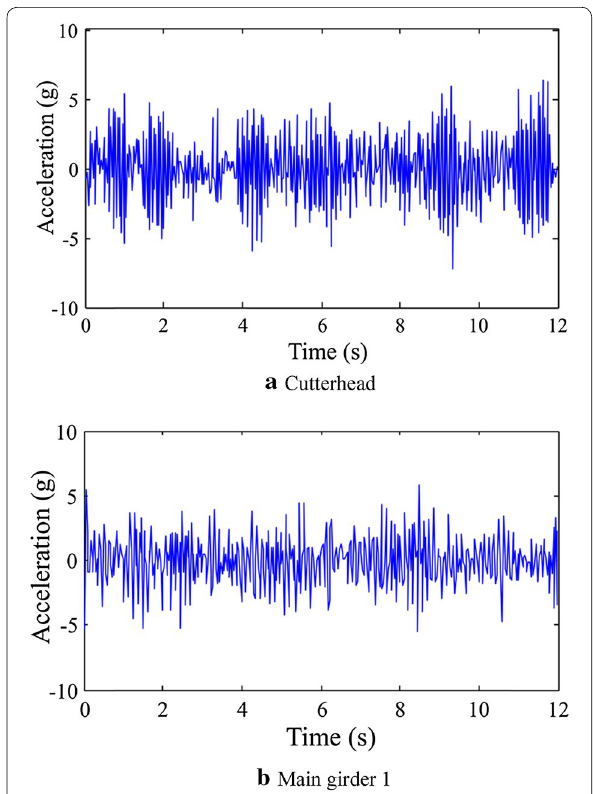
Figure 7 Vibration acceleration in the tunneling